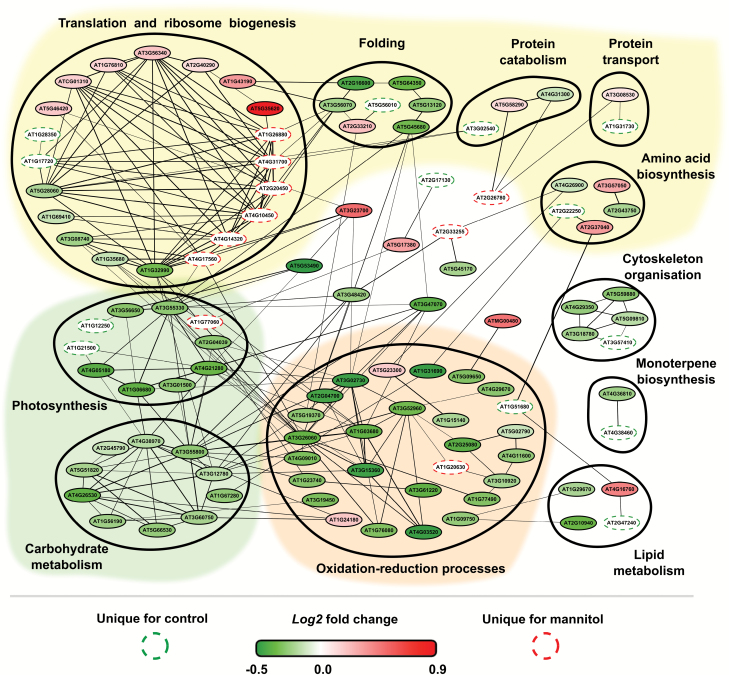
Functional protein association network of significant mannitol-regulated proteins (30 min treatment). GO annotations for biological process of differentially regulated proteins were superimposed on the network and nodes were grouped accordingly. Coloured backgrounds indicate functions related to protein metabolism (yellow), photosynthesis and carbohydrate metabolism (green), and oxidation–reduction processes (orange). Unique proteins were indicated with dashed lines, while differentially abundant proteins were coloured ranging from dark green to red depending on the log2 fold change. The thickness of connecting lines indicates a combined score of interaction.